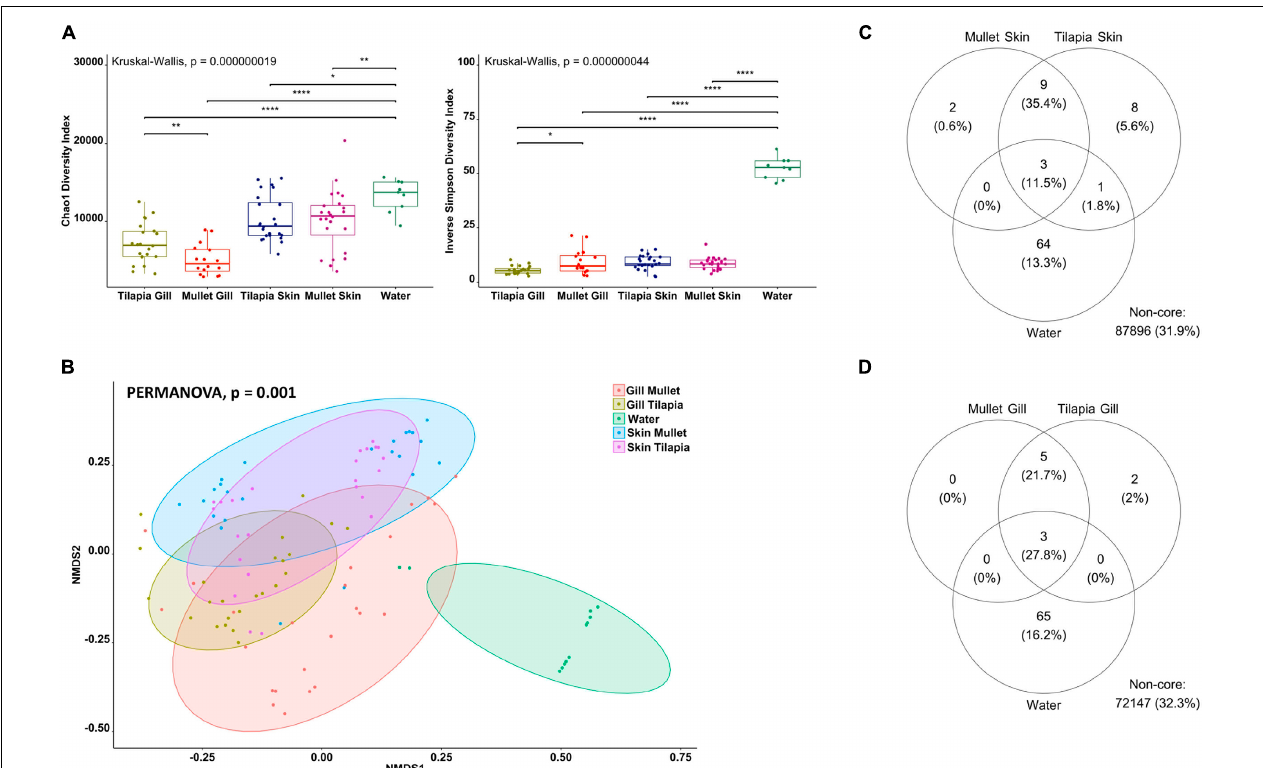
FIGURE 3 | Differential microbial communities in co-cultured Nile tilapia and grey mullet external surfaces and pond water ( n =24 fish/species and n =12 water) across two farms. (A) Alpha-diversity metrics of tilapia and mullet gill and skin microbial communities and pond water. Chao1 and Inverse Simpson were significantly different (Kruskal–Wallis, p < 0.00000001) in water compared with both species. Dots represent each individual sample, and * p < 0.05, ** p < 0.001 and **** p < 0.0001. (B) Non-metric multidimensional scaling (NMDS) plots based on Bray–Curtis similarity matrix of microbial communities [permutational multivariate ANOVA (PERMANOVA), p = 0.001]. The colors of the ellipses represent the different groups. (C) Venn diagram of shared and unique operational taxonomic units (OTUs) between tilapia and mullet gill and water. The numbers of OTUs with at least 0.1% of relative abundance in 80% of the samples are displayed. Numbers in brackets represent the average relative abundance of the OTUs in that group. (D) Venn diagram of shared and unique OTUs between tilapia and mullet skin and water.